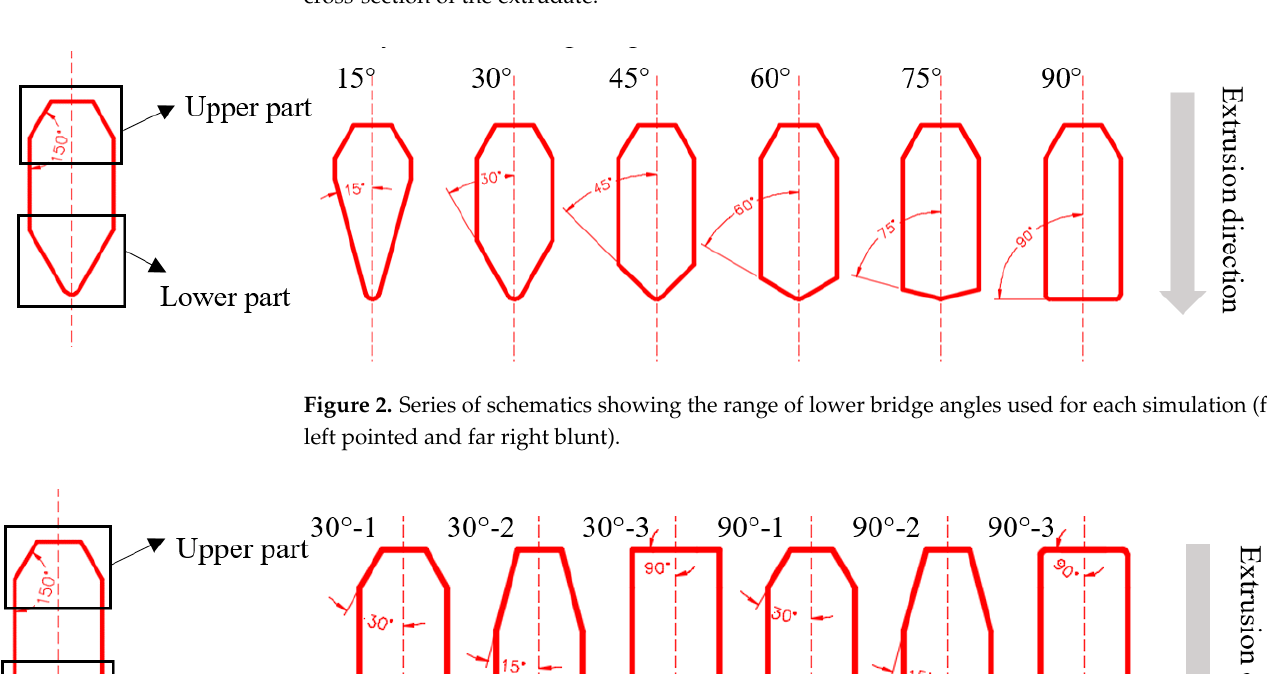
Figure 1. Schematic showing the porthole die used for this study showing: ( a ) a cut-away view of the porthole die assembly, ( b ) a cross-sectional view showing the dimensions of the die and ( c ) the cross-section of the extrudate.